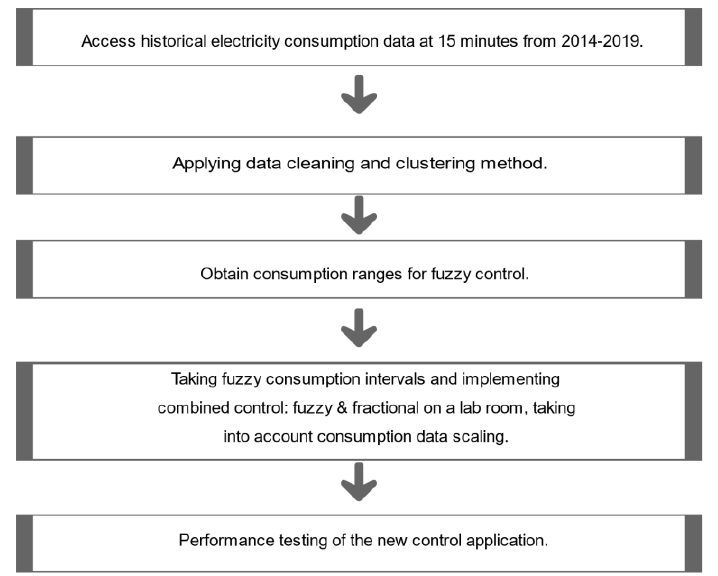
Figure 8. The proposed experimentation